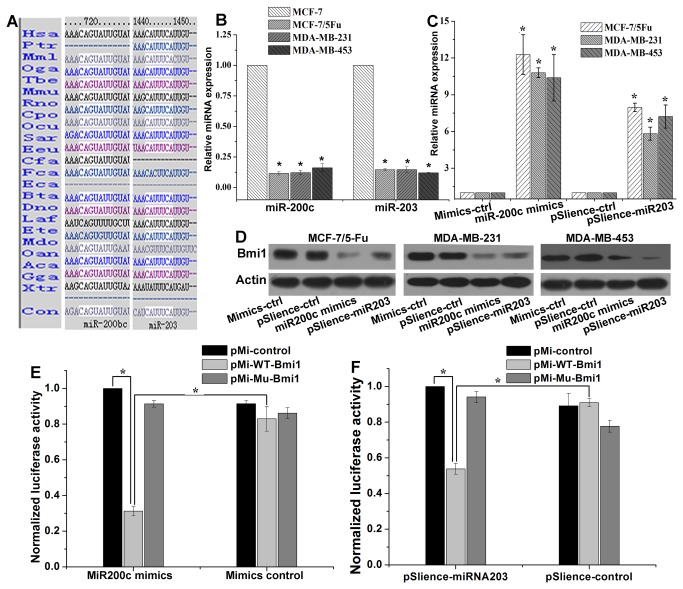
miR-200c and miR-203 target Bmi1 expression.(A) Schematic of predicted miR-200c and miR-203 sites in the human Bmi1 3′UTR broadly conserved among vertebrates; (B) miR-200c and miR-203 expression status in selected cell lines, verse MCF-7 * p<0.01; (C) miR-200c mimics and miR-203 expression vector increased miR-200c and miR-203 expression, verse control * p<0.01; (D) Inverse relationship between miR-200c and miR-203 and Bmi1 protein levels was showed; (E) and (F) Mir-200c and miR-203 suppressed the activity of the luciferase gene linked by the 3′UTR of Bmi1 respectively and a Renilla luciferase reporter for normalization. The data was obtained from three independent experiments. The mean of the results from 293T cells transfected with pMir-control and miR-200c mimics or pSlience-miR-203 were set as 1.0 respectively, * p<0.01.